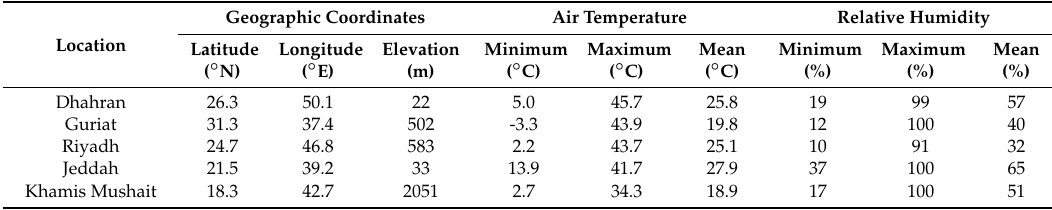
Figure 6. The climatic zones in Saudi Arabia [60]. Table 1. Climatic parameters for the represented locations [61].